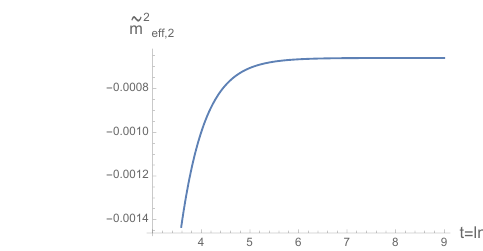
m 2 > 0 and m 2 < 0 at all temperatures indicating the absence e e eff , 1 eff , 2